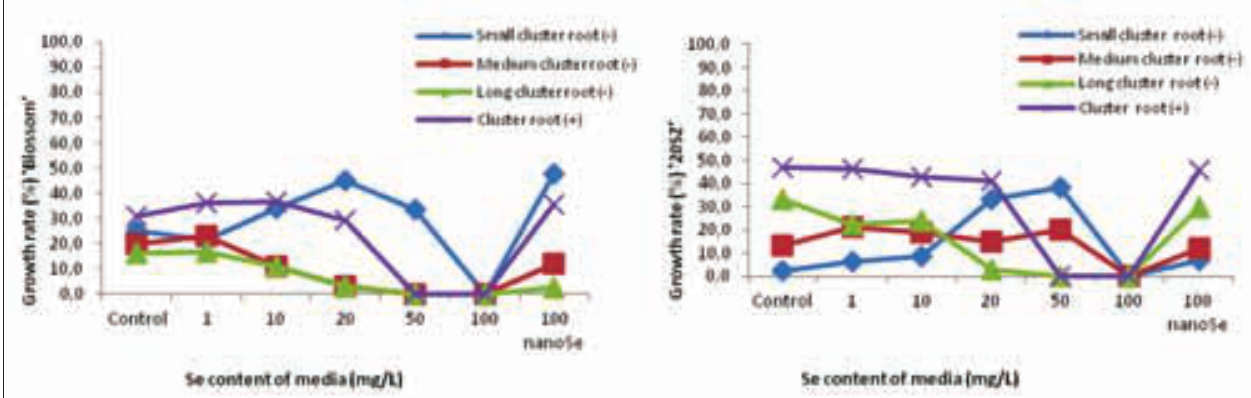
Fig. 2: Growth rate of Blossom and 20SZ Arundo donax L. embryo-derived germinated clusters treated with 0; 1; 10; 20; 50; 100 mg L -1 sodium-selenate or red elemental nanoselenium suspension (100 mg L -1